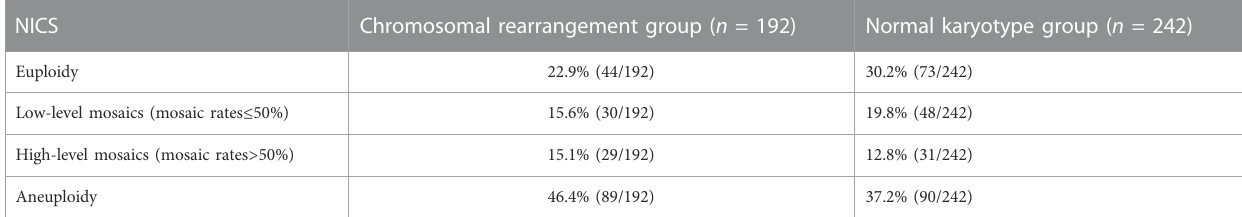
TABLE 2 Comparison of different NICS results between the normal chromosome group and rearrangement